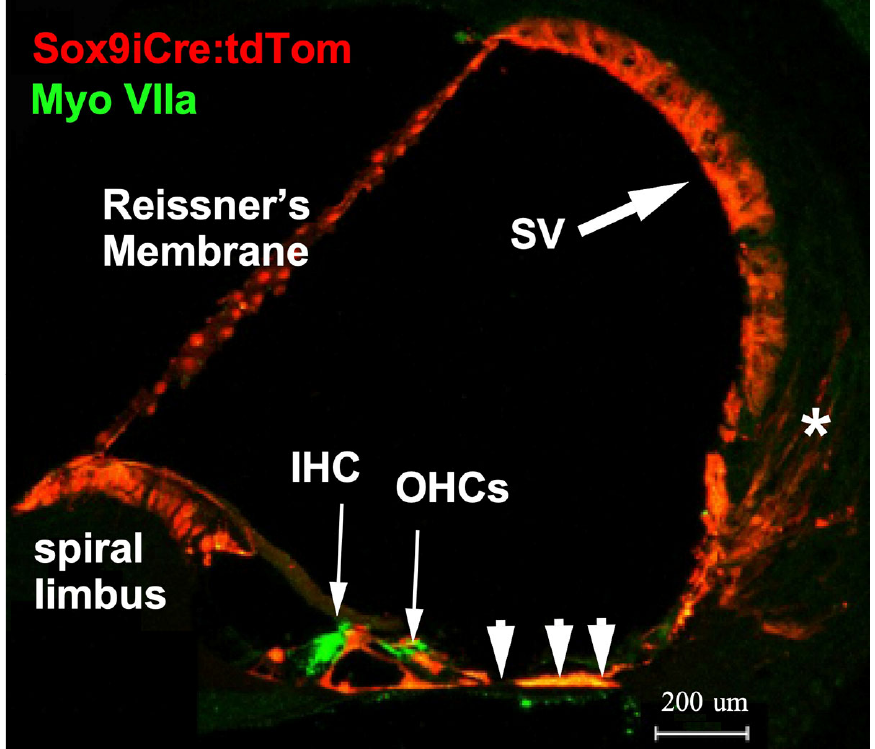
Figure 1. Cre recombinase activity was assessed in the mouse cochlea. Transgenic mice produced to carry a BAC clone containing the promoter region of the Sox9 gene and an ERT2 inducible Cre recombinase were bred with the Ai14 tdTomato mouse line. Tamoxifen treatment activates the Cre recombinase that then removes the stop codons in front of the tdTomato reporter sequence. All cells with tamoxifen-activated Cre recombinase then express the red fluorescent tdTomato reporter gene. In the adult cochlea, cells that harbor activatable Cre recombinase include interdental cells and inner sulcus cells (poorly visible here) of the spiral limbus, pillar cells and Deiter’s cells, supporting cells lateral to the outer hair cells (arrowheads), cells of the spiral prominence, cells of the stria vascularis (SV, large arrow), and a scattering of Type II fibrocytes of the spiral ligament (asterisk).